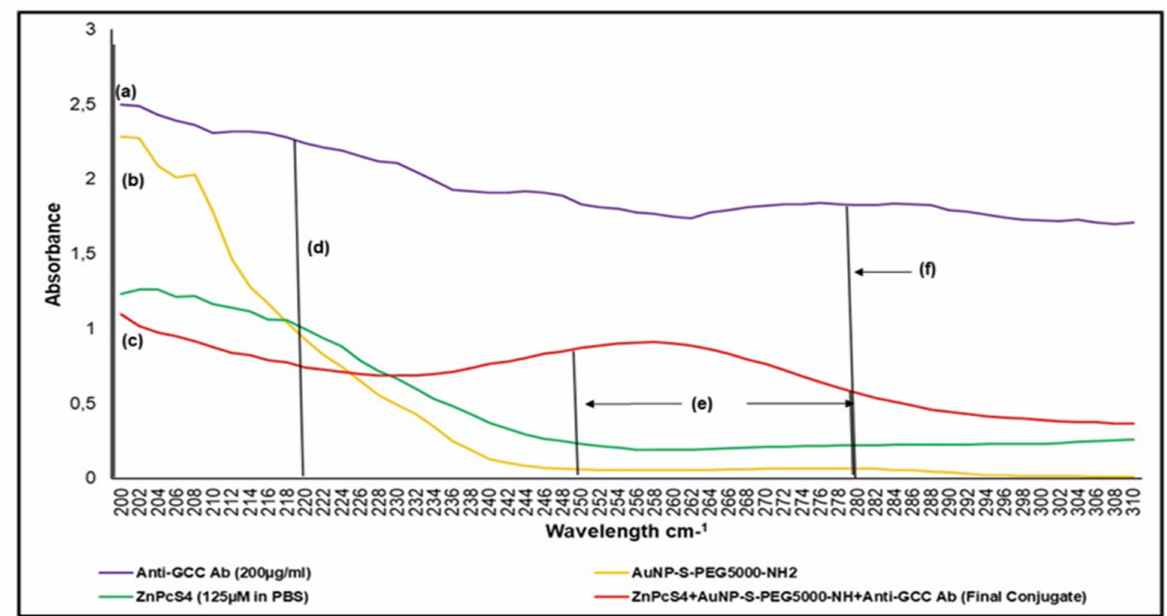
Figure 4. UV-visible protein direct-absorption spectra of the BNC and various controls, acquired between the 200 to 310 nm spectral region, to determine protein presence, as well as amide and disulphide bond confirmation. ( a ) amine NH 2 195 nm group on Ab n’ terminal, ( b ) amine NH 2 195 nm group on functionalized AuNPPEG-NH 2 , ( c ) amine NH 2 195 nm group on final conjugate Ab n’ terminal (Ab functional), ( d ) peptide/amide bond 220 nm of final conjugate (functionalized AuNPPEG-NH 2 lost amine group to bond with carboxyl c’ terminus of Ab and form a peptide bond), ( e ) disulphide bond 250 to 280 nm (ligand exchange process was performed in the presence of air and, thus, caused ZnPcS 4 to form a dimer), and ( f ) anti-GCC Ab protein 280 nm 200 µ g/mL (6.47 times higher absorbance than final BNC conjugate, thereby suggesting final concentration of Ab within the BNC molecule was 30.91 µ